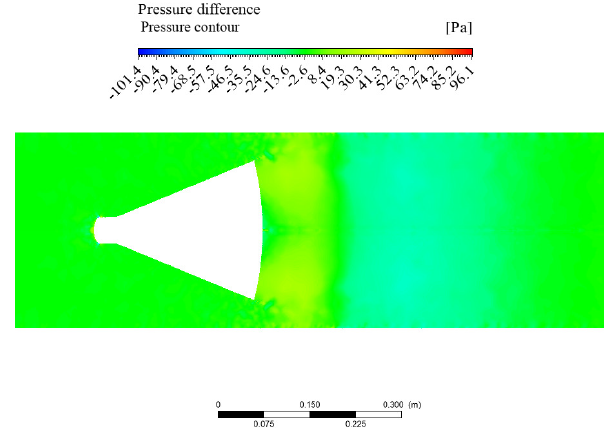
Figure 13. Contour plot of the pressure difference between the original mesh and the refined one, proposed cone.